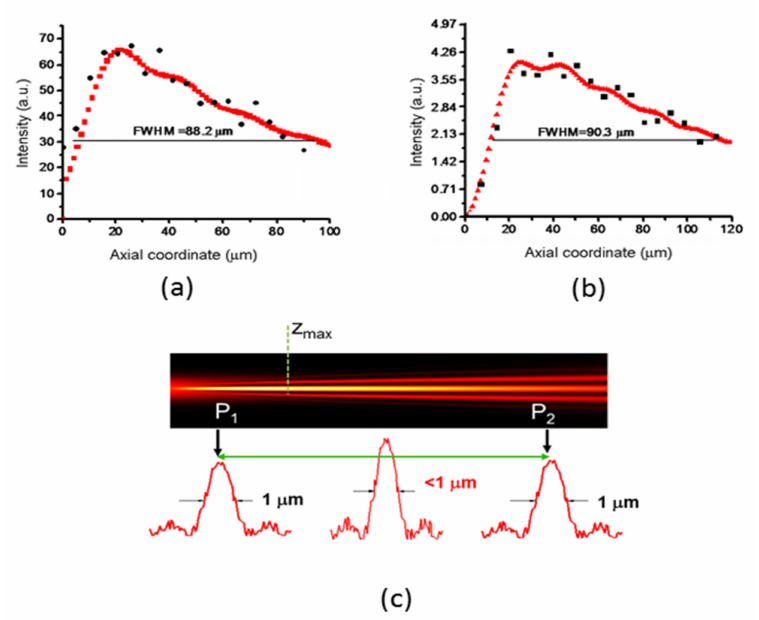
Figure 12. Upper part: Measured (black dots) and theoretical (red dots) light distributions in the focal lines for ( a ) λ 1 = 633 nm and ( b ) λ 2 = 405 nm. ( c ) Definition of the focal LFRB line P 1 P 2 , within which the FWHM spot diameter is